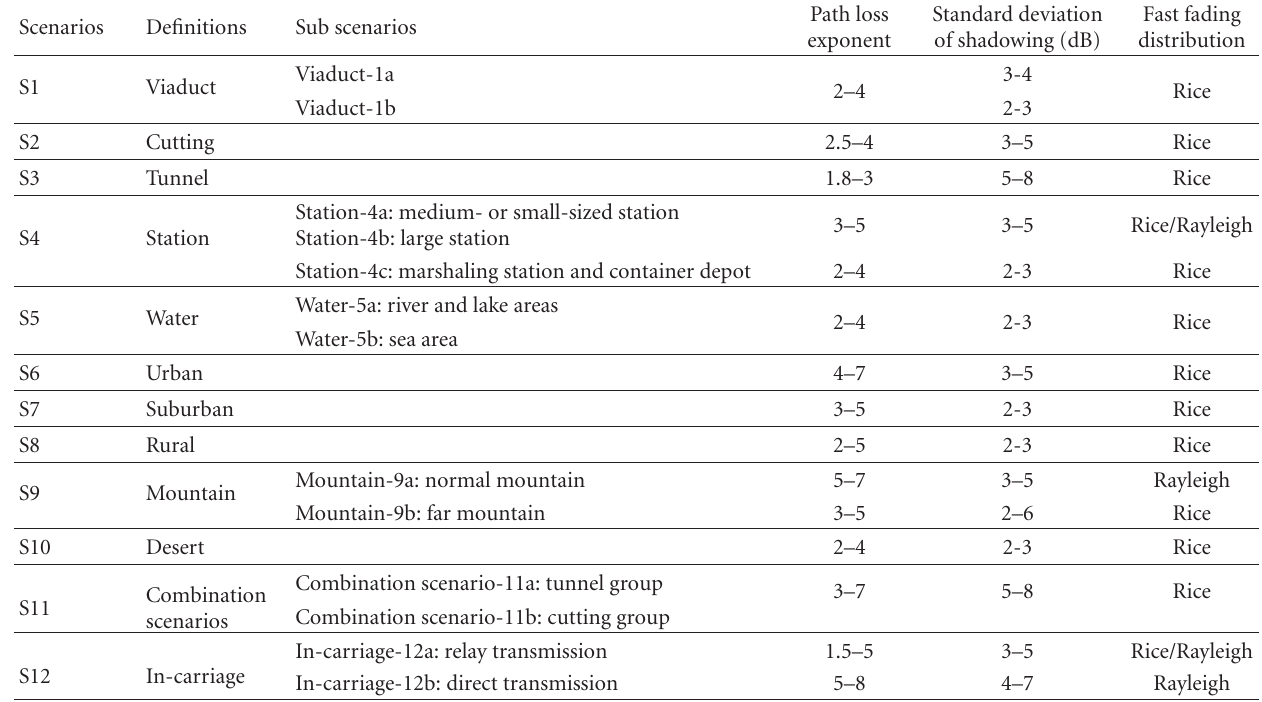
Table 2: Predicted values of modeling parameters for HSR scenarios at 930